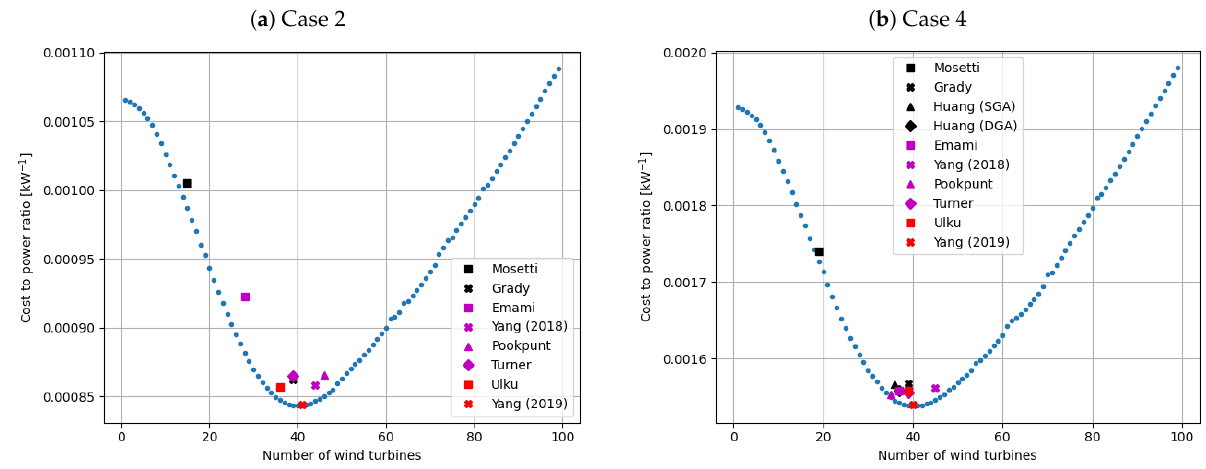
Figure 17. Fitness function value comparison for cases 2 and